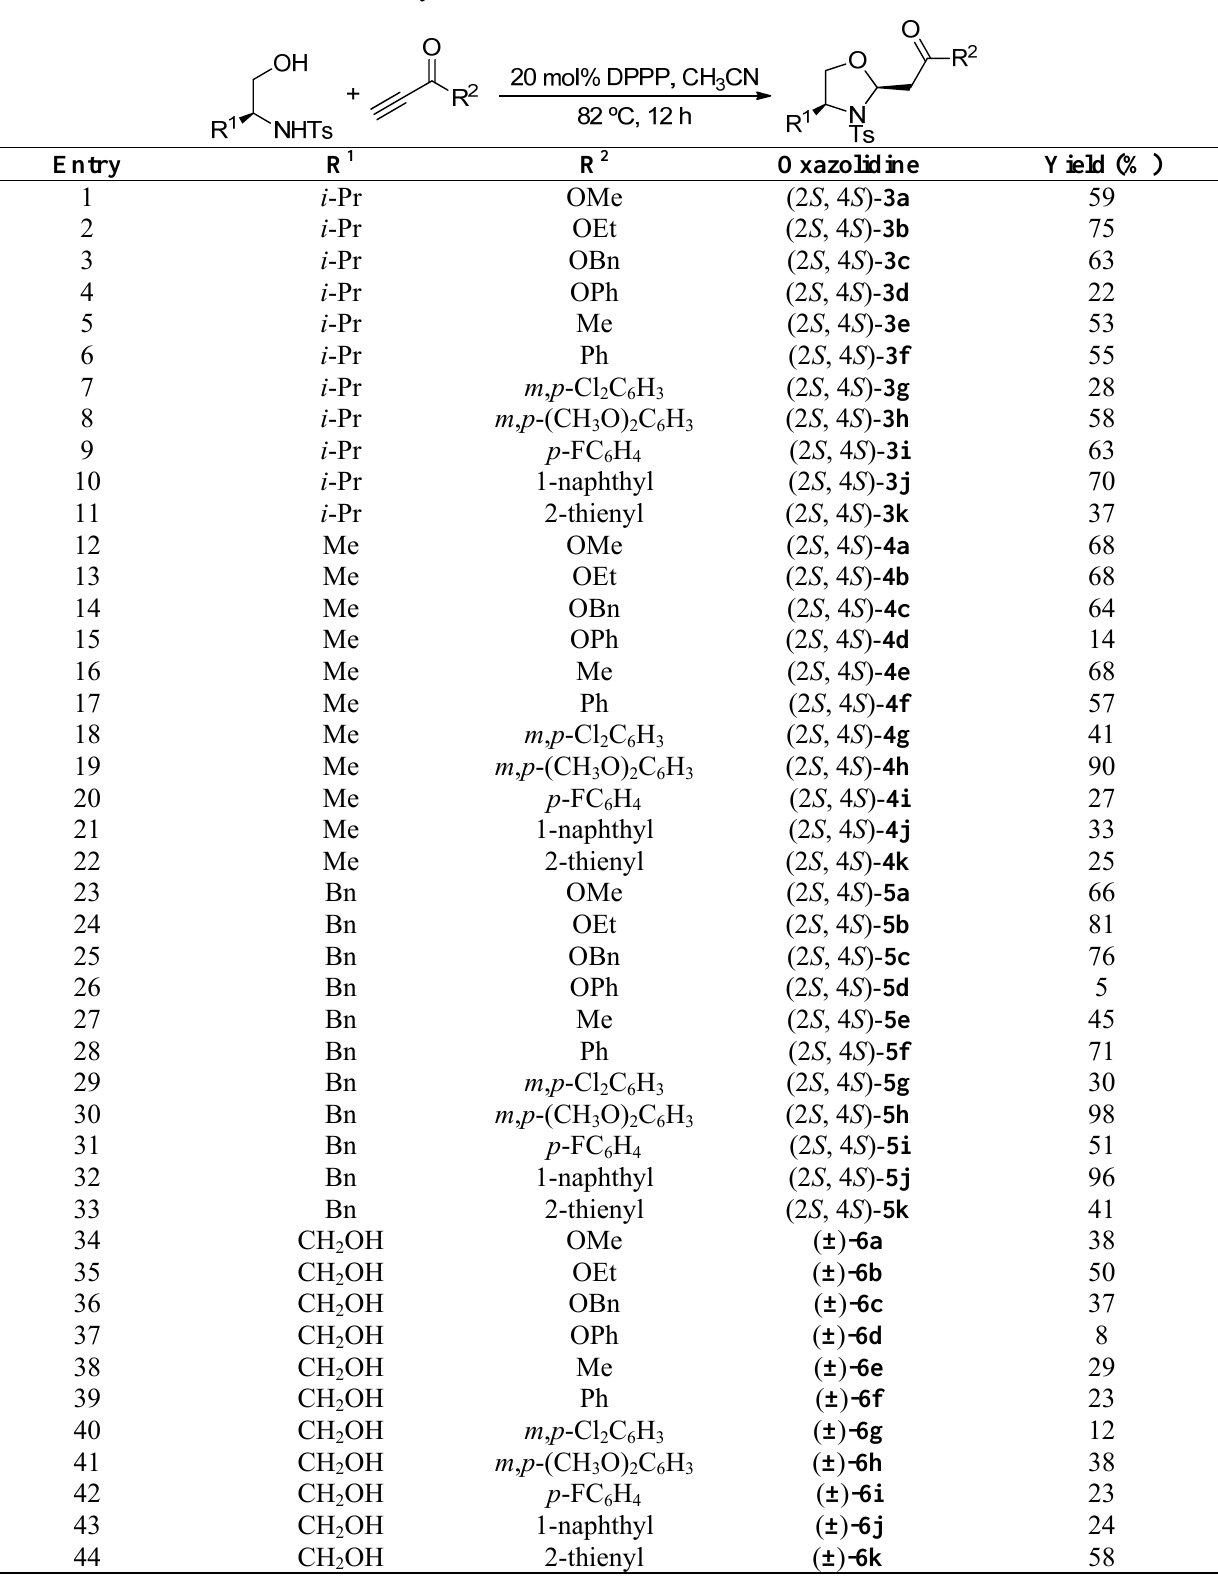
Table 2. Synthesis of Trisubstituted